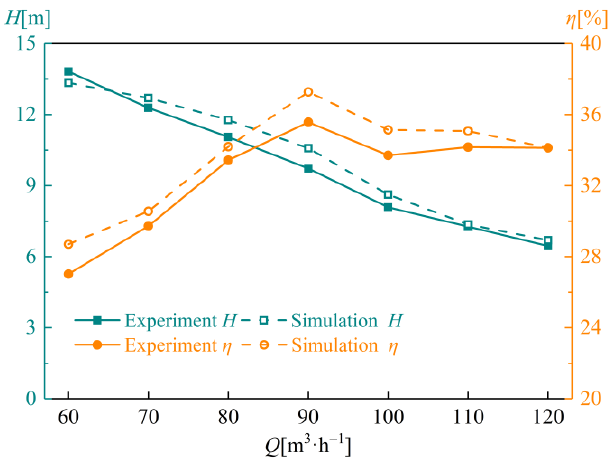
Figure 5. External characteristics of a multiphase pump in the water condition.